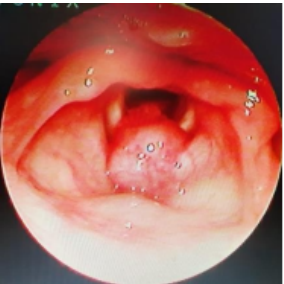
Figure 3. Ulcero-proliferative mass over anterior commissure- glottic malignancy